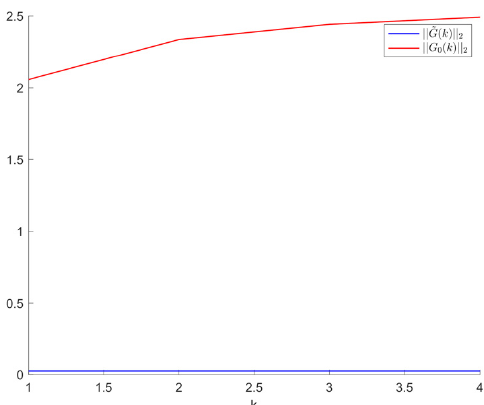
Figure 12. Relation between the 2-norm of the uncontrolled matrix G 0 ( k ) and error matrix (cid:101) G ( k ) in Example 6.